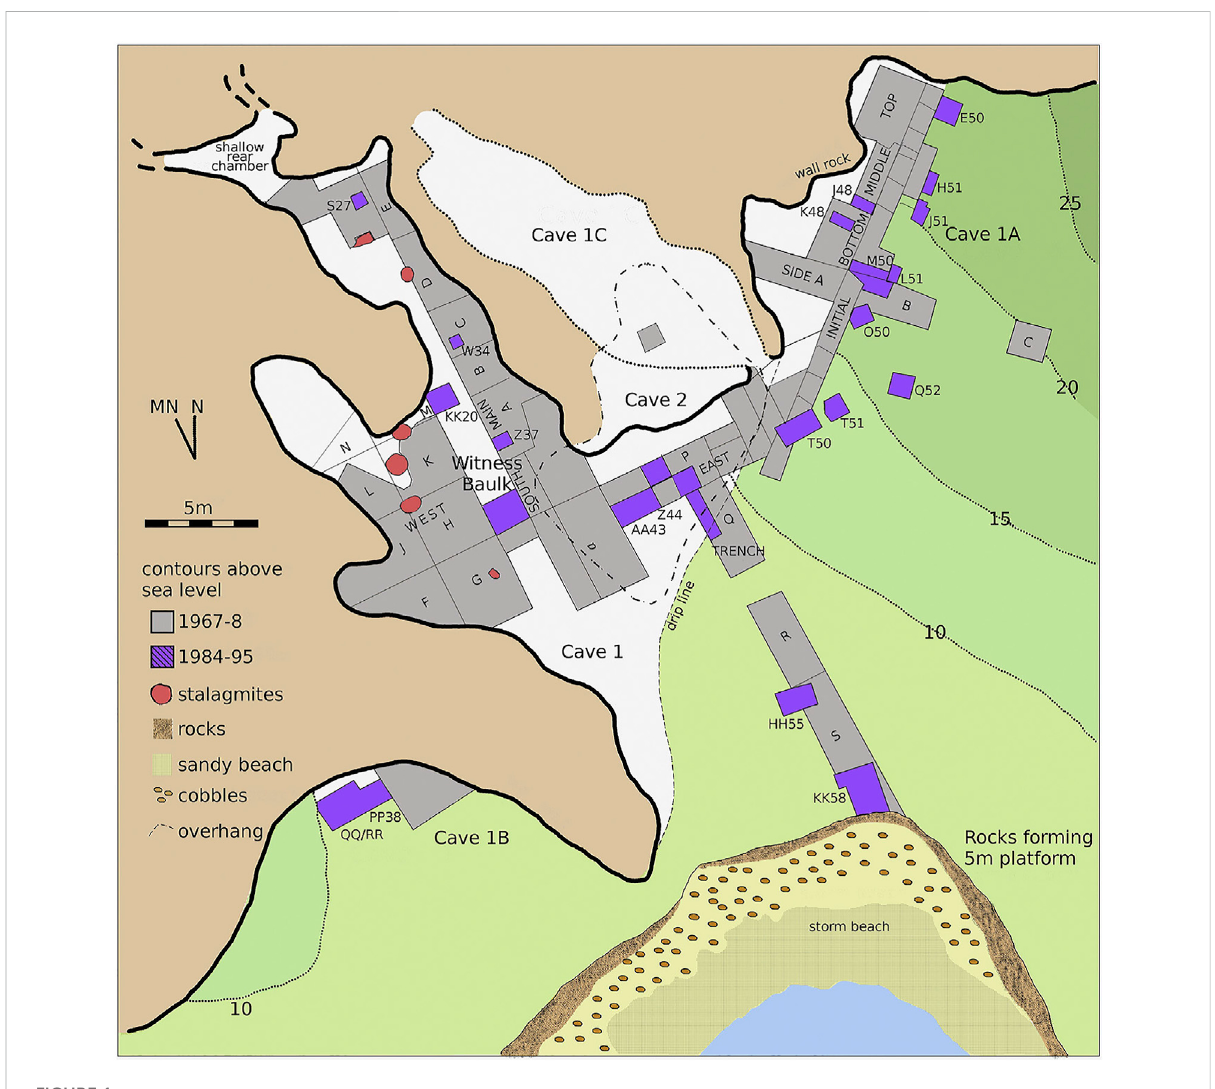
FIGURE 1 Site map of Klasies River main